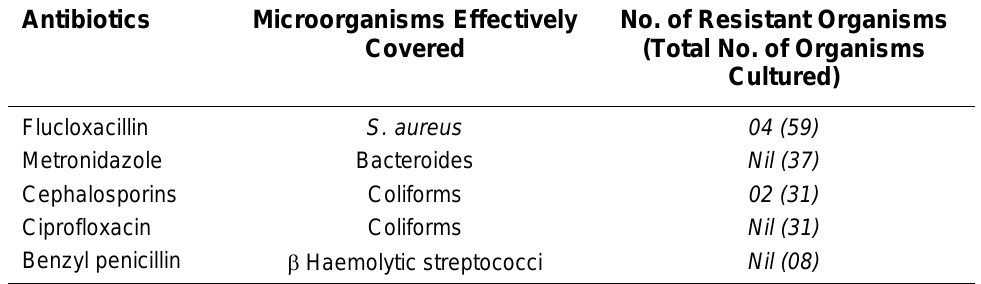
Antibiotics, Coverage of Microorganisms, and the Degree of Microbial Resistance